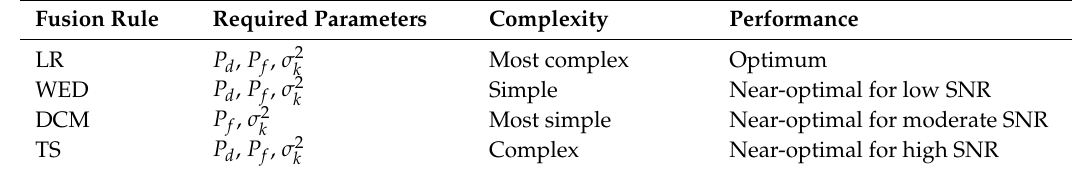
Table 2. Comparison of the fusion rules.